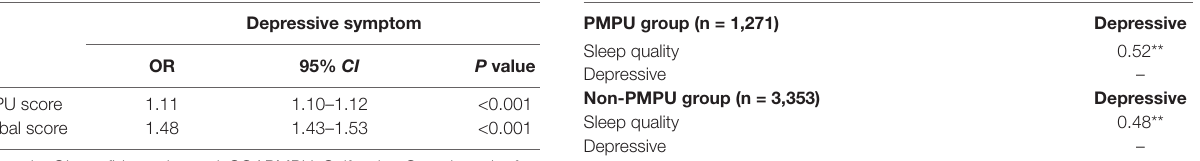
TABlE 2 | Results of logistic regression. TABlE 3 | Correlation of the variables in PMPU and non-PMPU group.